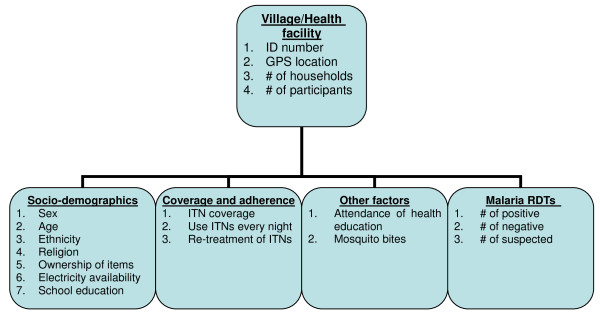
Database components.